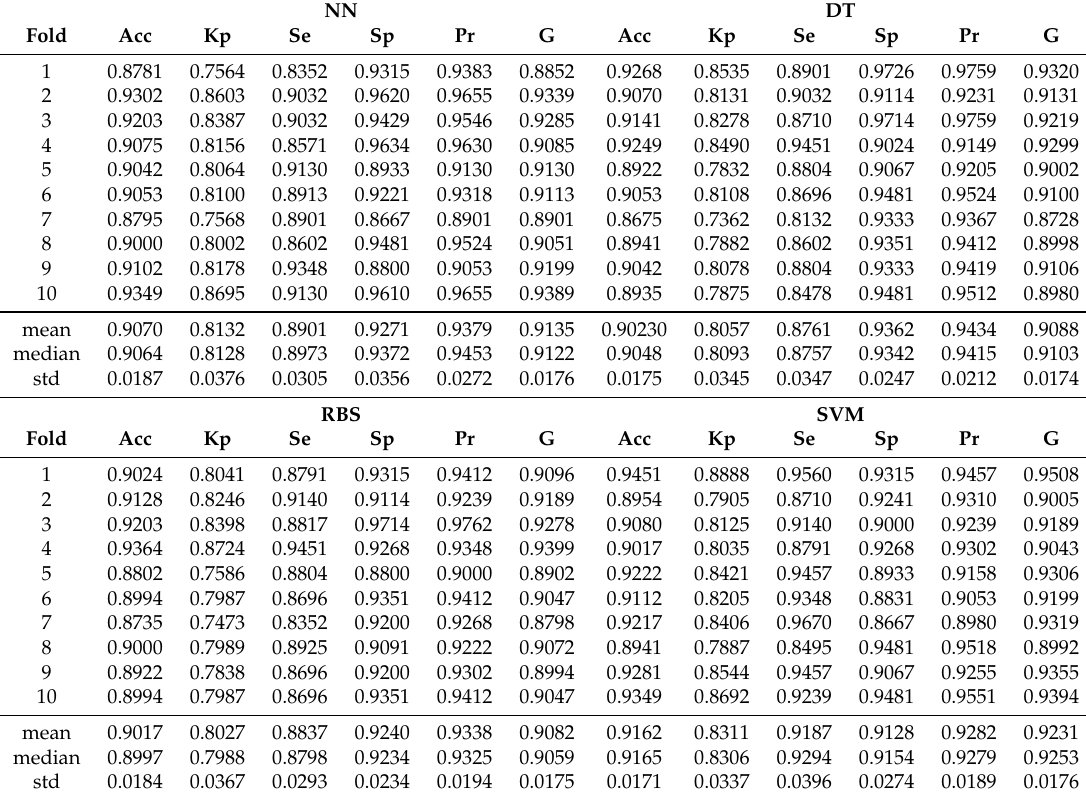
Table 9. Results obtained from the 5 × 2 cv when the threshold is set to 3.0 × g : the different statistics are the Accuracy (Acc), Kappa factor (Kp), Sensitivity (Se), Specificity (Sp), Precision (Pr) and the geometric mean (G), all of them computed using Equations (1) to (8). The three different models are feed forward NN, Support Vector Machines (SVM), Decision Trees learned with C5.0 (DT) and Rule-Based Systems learned with C5.0